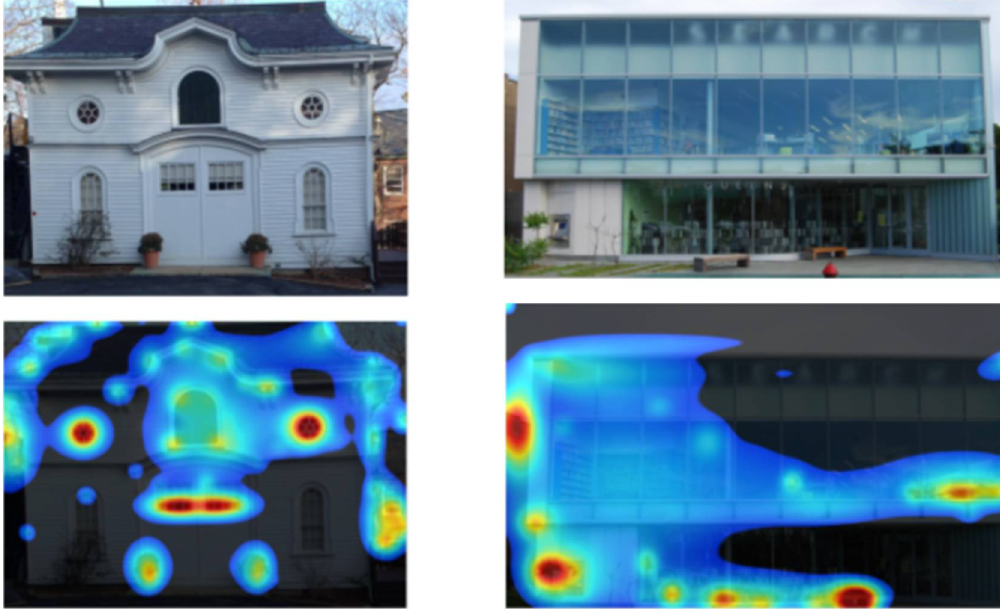
Figure 5. Recordings obtained with a Visual Attention Software on the two photographs of a Carriage House (Massachusetts) on the left and of the Queens Library at Glen Oaks (New York City). The red points are those on which the the observer’s eye stopped for a longer time. Photos and research by Ann Sussman© geneticsofdesign.com